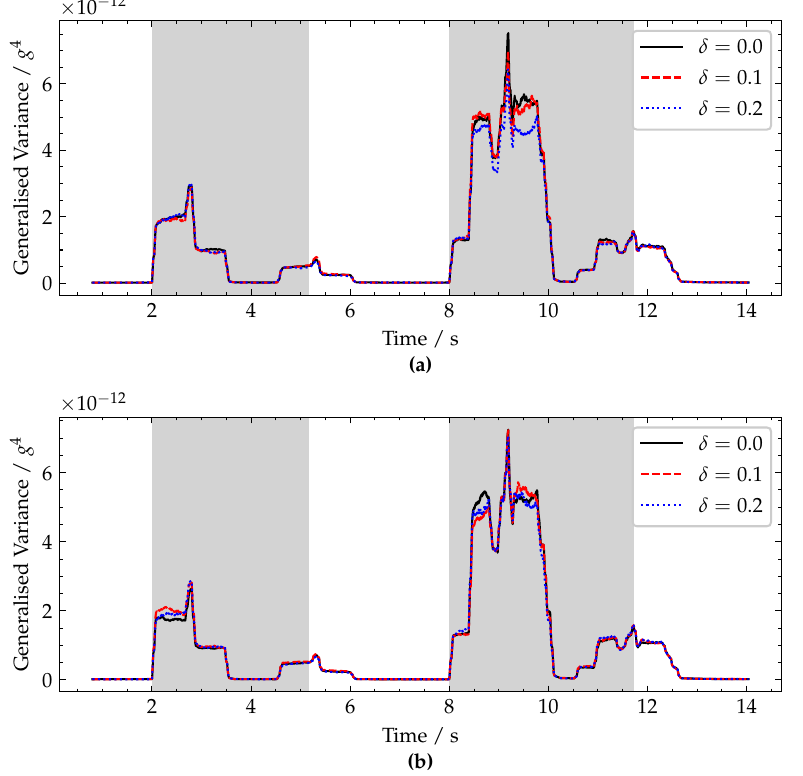
Figure 11. Plot of generalised variance for varying damage severity, δ , with the damage located at ( a ) mid-span and ( b ) quarter-span. Periods when a vehicle is crossing the bridge are shaded